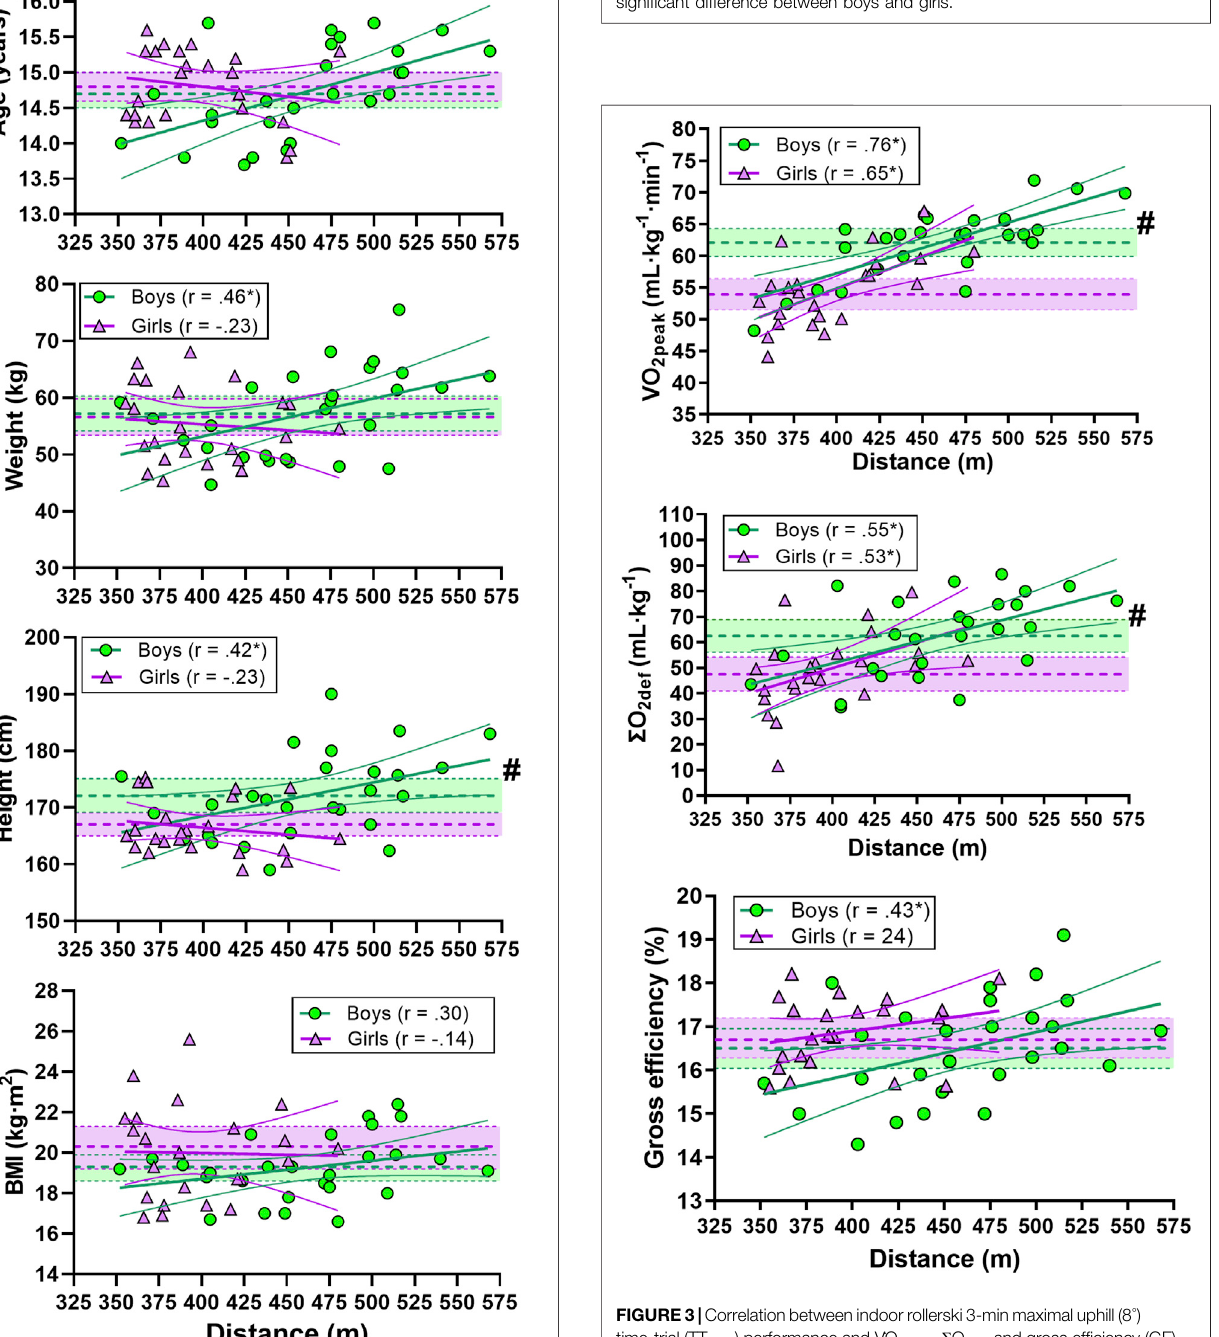
FIGURE2| boysandpurpleforthegirls).Thickandnarrowlinesrepresentthe best fi t regression lines and the 95% con fi dence bands (green lines for the boys and purple for the girls). * Correlation is signi fi cant at the 0.05 level. # signi fi cant difference between boys and girls.